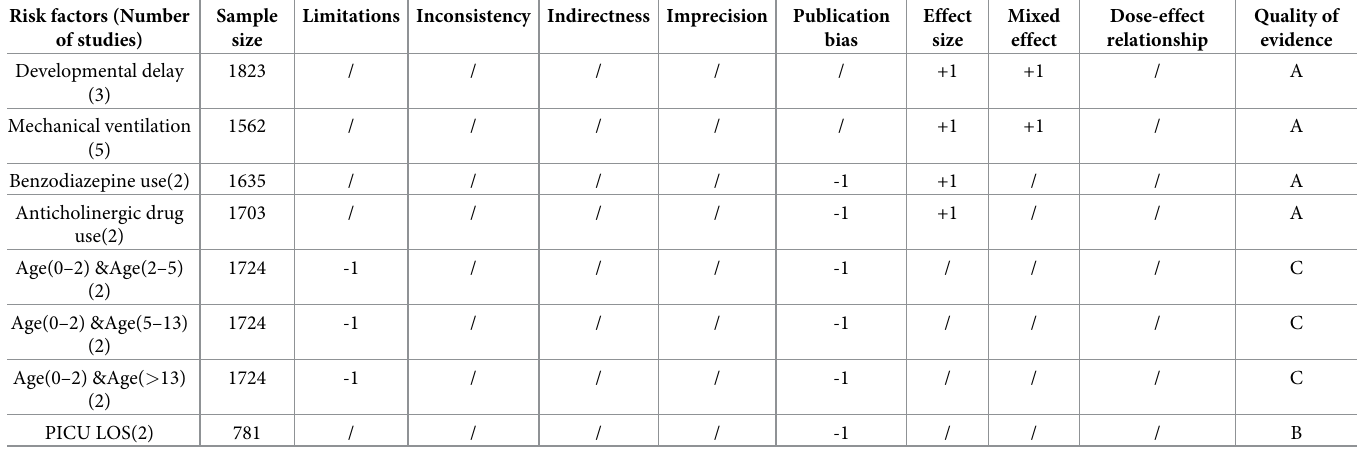
Table 3. Assessment of evidence level based on GRADE system.